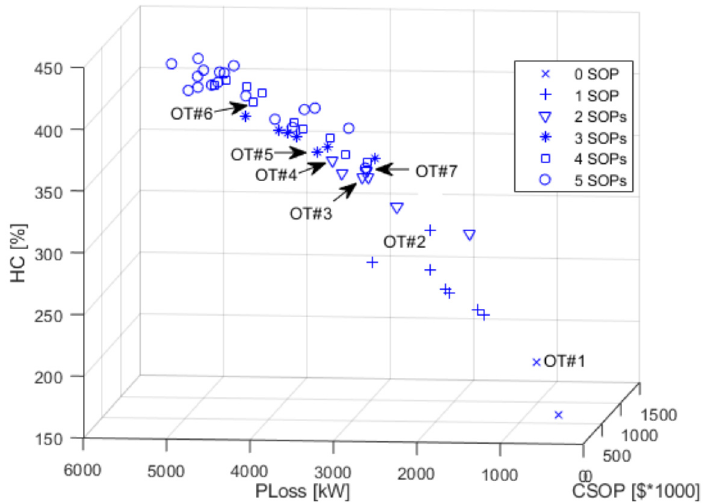
Figure 13. 2-D Pareto front (PLoss × HC).